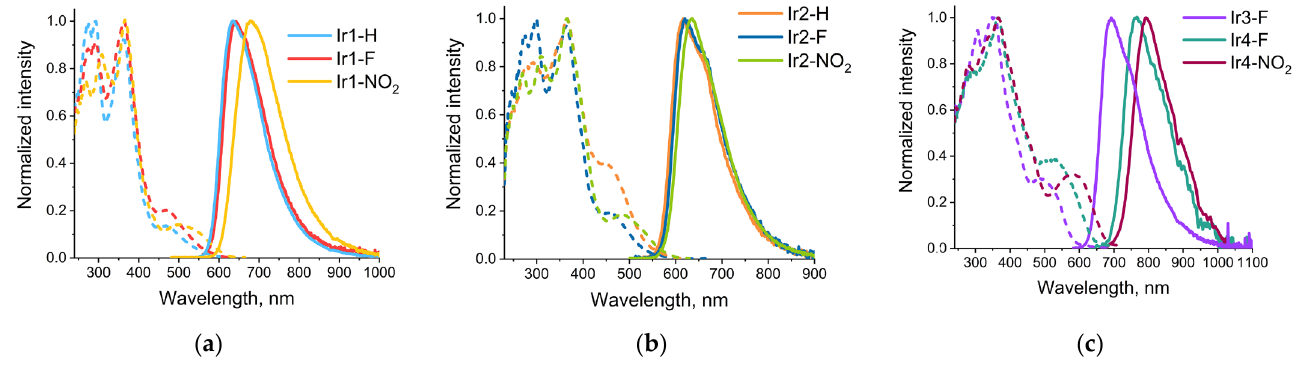
Figure 3. Normalized excitation (dashed line) and emission (solid line) spectra of iridium complexes: ( a ) Ir1-H, Ir1-F, Ir1-NO 2 ; ( b ) Ir2-H, Ir2-F, Ir2-NO 2 ; ( c ) Ir3-F, Ir4-F, Ir4-NO 2 .